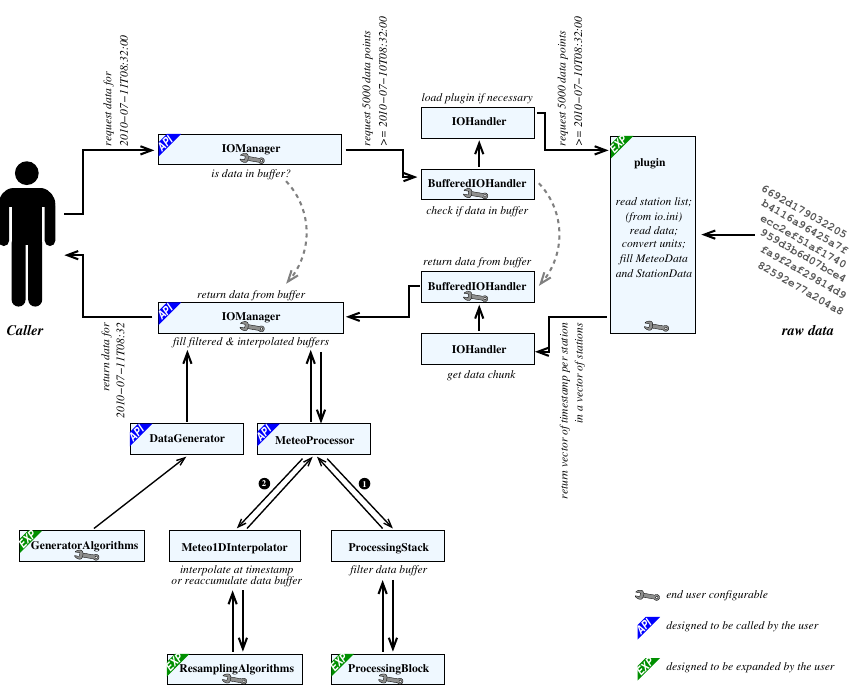
Figure 5. Meteorological data reading and processing workflow. The classes marked API are designed to be called by the user and the classes marked EXP are designed to be expanded by the user.